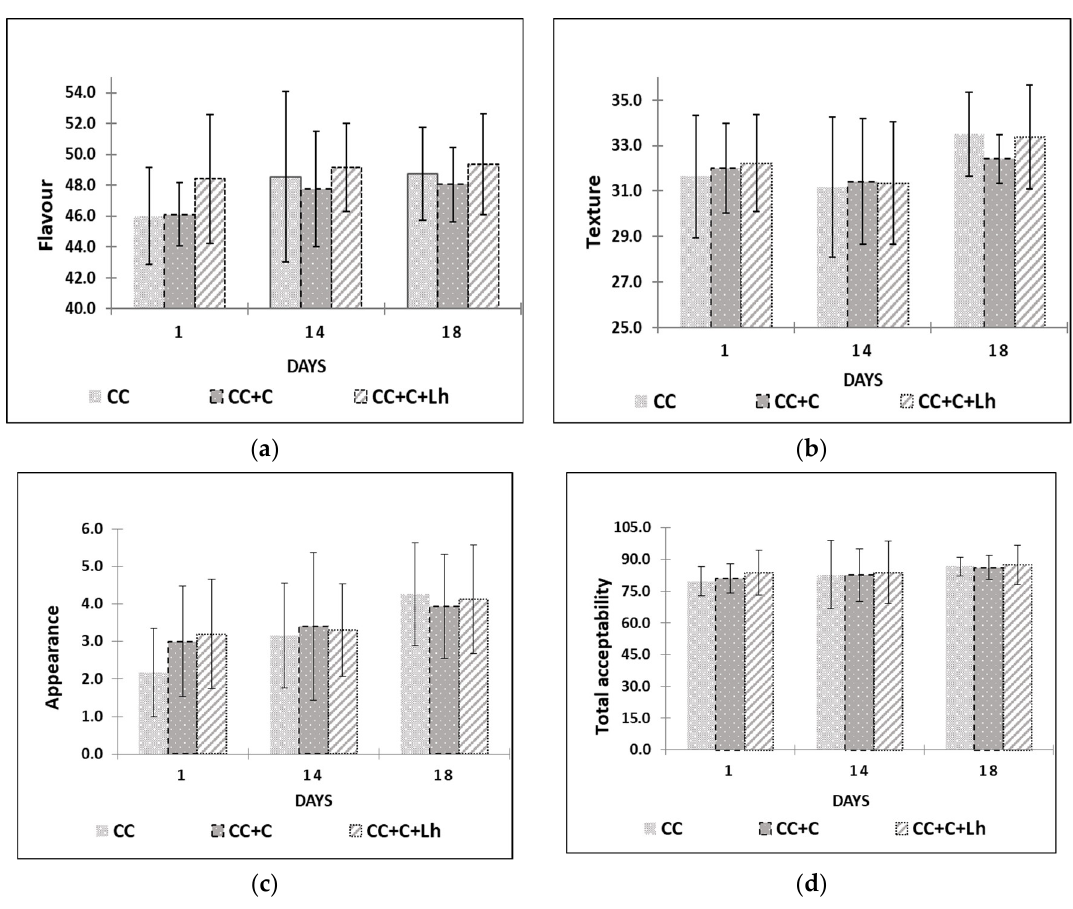
Figure 4. Flavour ( a ), body and texture ( b ), appearance ( c ), and overall acceptability ( d ) are presented for control curd cheese (CC), coated curd cheese (CC + C), and coated cheese with L. helveticus (CC + C + Lh) during 18 days of sensory evaluation (mean values ± SD).